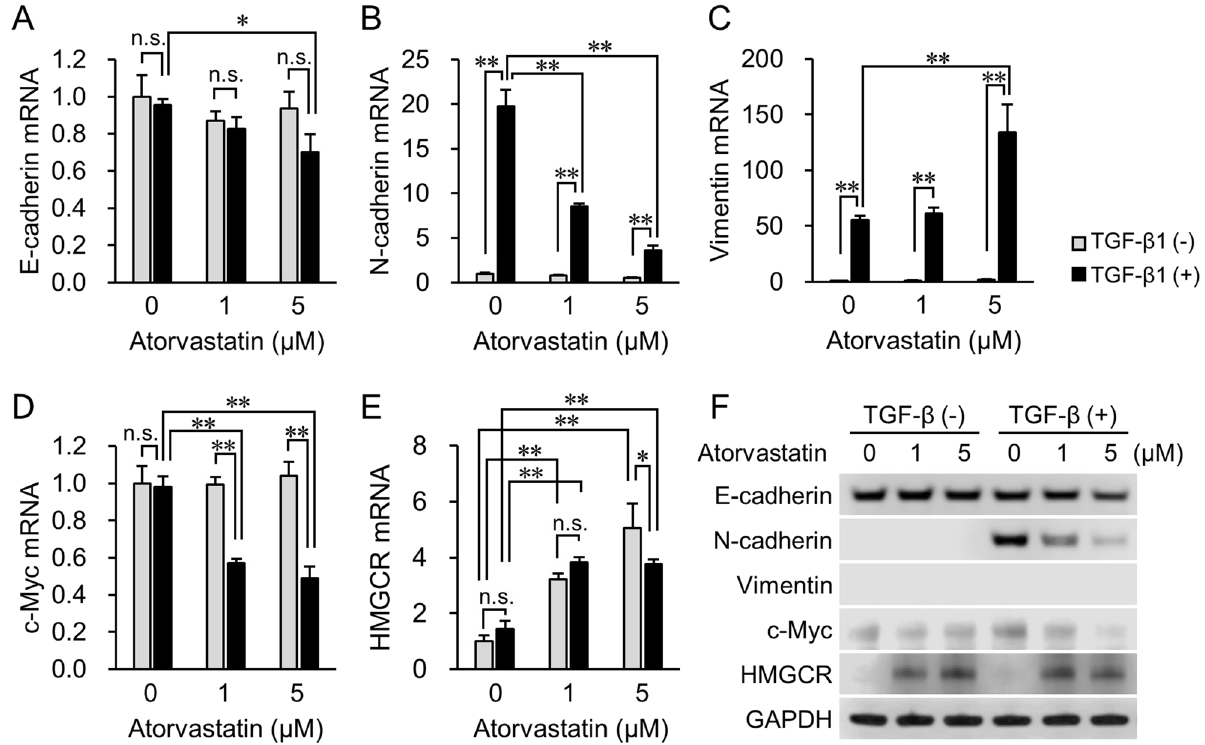
Figure 4. mRNA and protein expression levels of EMT-related molecules, regulator of cell proliferation, and target of statins in TGF-β (−) and TGF-β (+) groups. Real-time PCR analyses of expression of ( A ) E-cadherin, ( B ) N-cadherin, ( C ) vimentin, ( D ) c-Myc, and ( E ) HMGCR genes after the start of TGF-β1 incubation. Cells incubated with PBS are designated as TGF-β1 (−). Data are normalized to 18S rRNA levels in each sample and expressed as values relative to those of the internal control. The measurement values for each group are compared using the Bonferroni-Dunn post-hoc test. Mean ± SD, n = 3, * p < 0.05, ** p < 0.01, n.s. not significant. ( F ) Western blot analysis of the expression of E-cadherin, N-cadherin, vimentin, c-Myc, and HMGCR after induction with TGF-β1. GAPDH expression is used as the loading control. Representative images from three independent experiments are